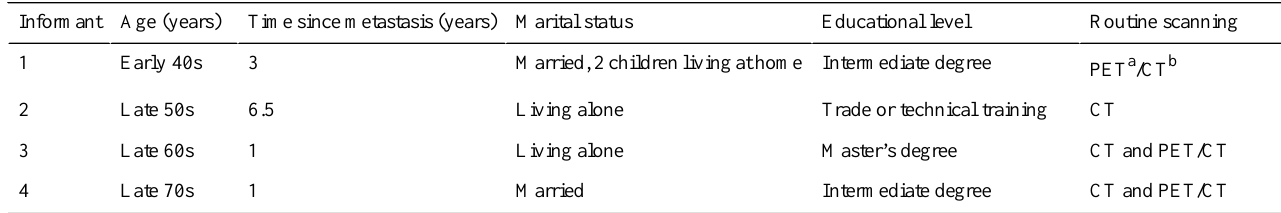
Table 2. Overview of the 4 women selected for individual